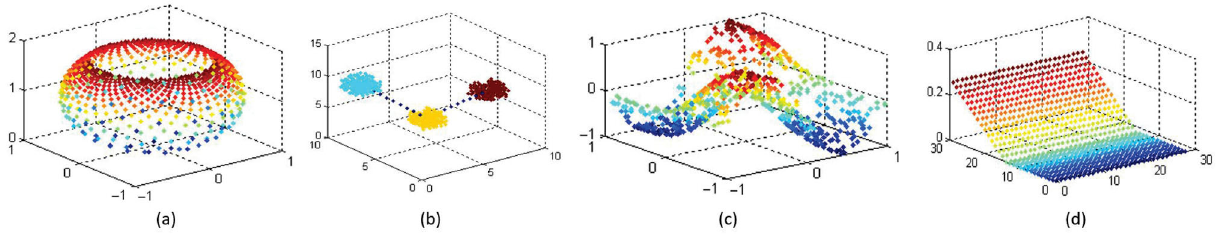
Fig. 2 Toy datasets: (a) puncturedsphere , (b) 3 D clusters , (c) twinpeaks , and (d) corner